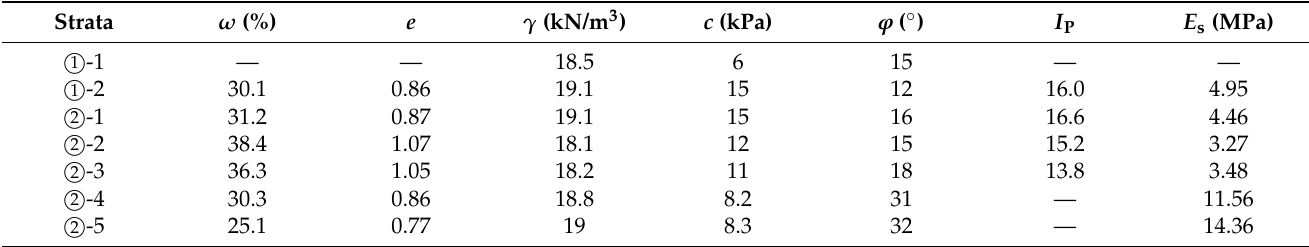
Table 6. Physical and mechanical parameters of strata at the site.